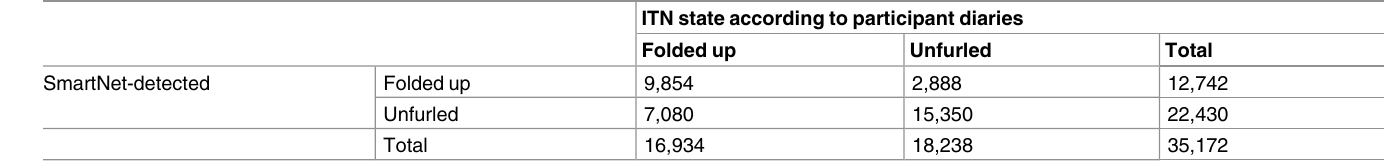
Table 4. 2x2 table of SmartNetversus diary ITN state.